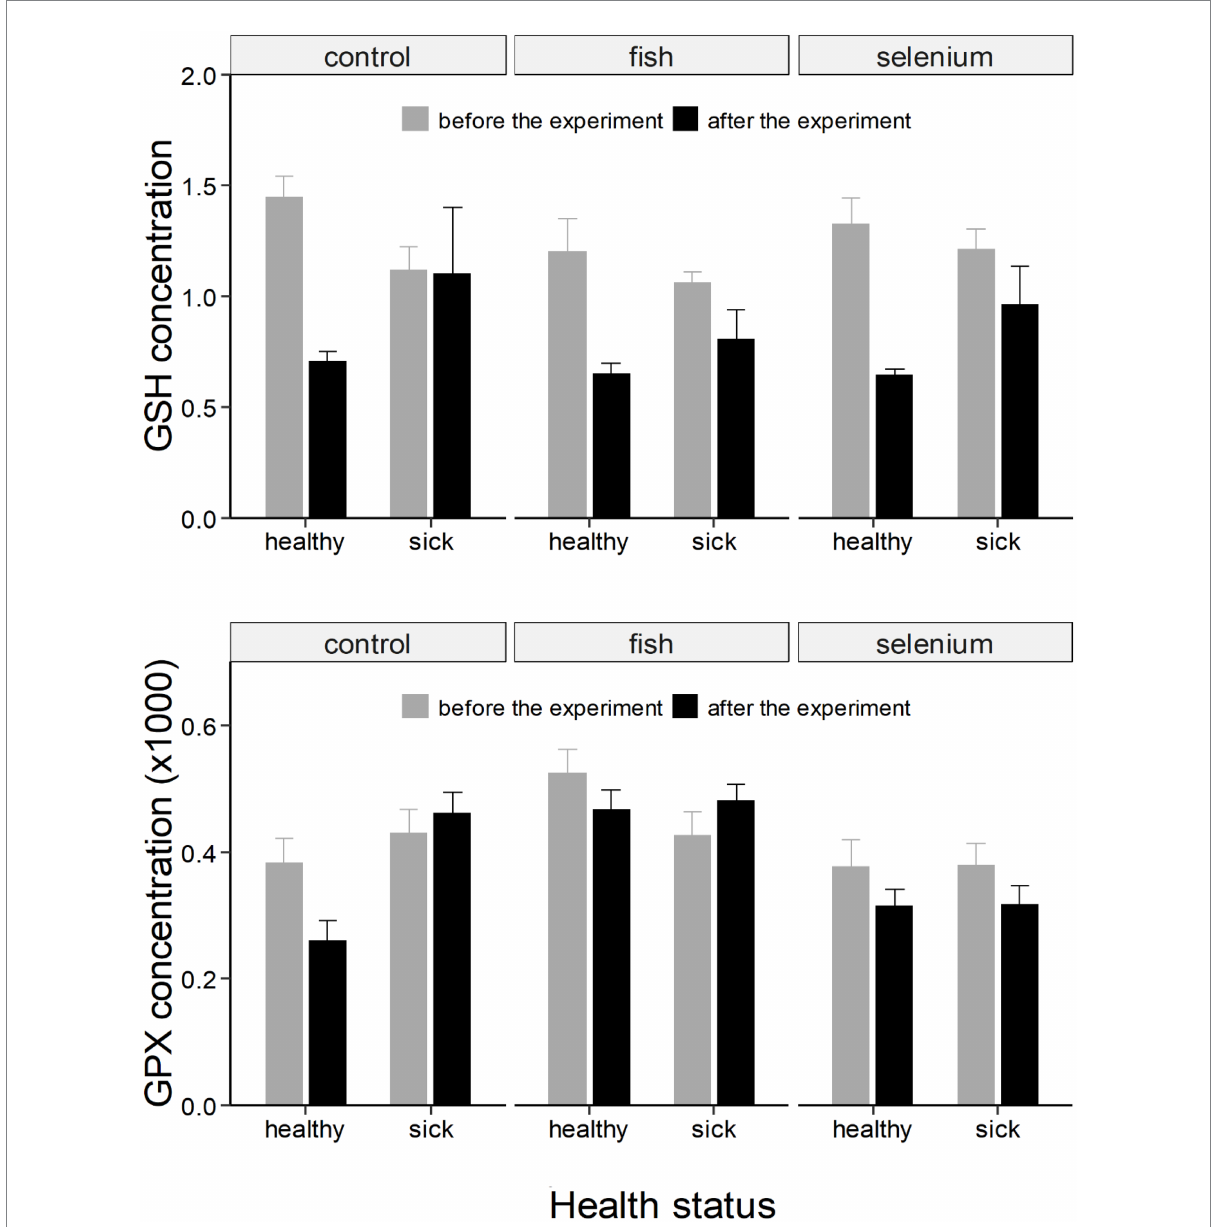
FIGURE 2 GSH (expressed as as μ mol/g of fresh weight) and GPx (expressed as μ mol NADPH/mg protein per minute) concentrations (± SE) in chicks divided based on the health status and experimental group (control, fish supplemented, or Se supplemented). Concentrations are further divided and represented as “before the experiment” (grey column) and “after the experiment” (black column). GPx concentrations were multiplied by 1,000 for an optimal graphic